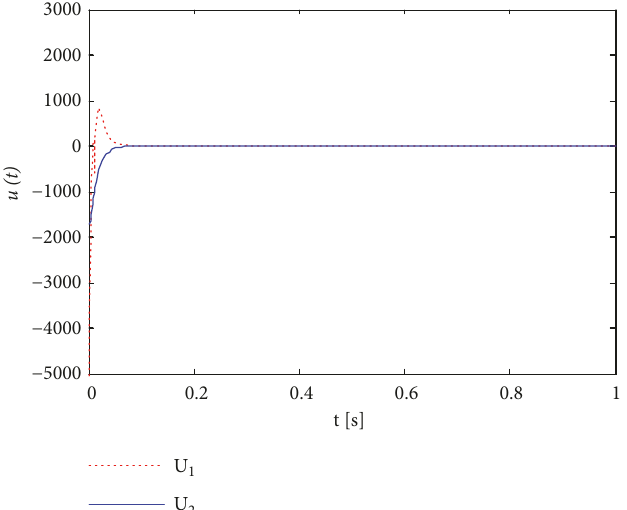
Figure 6: The state control curve of the closed-loop system under the control of the memory state feedback controller when the initial value is